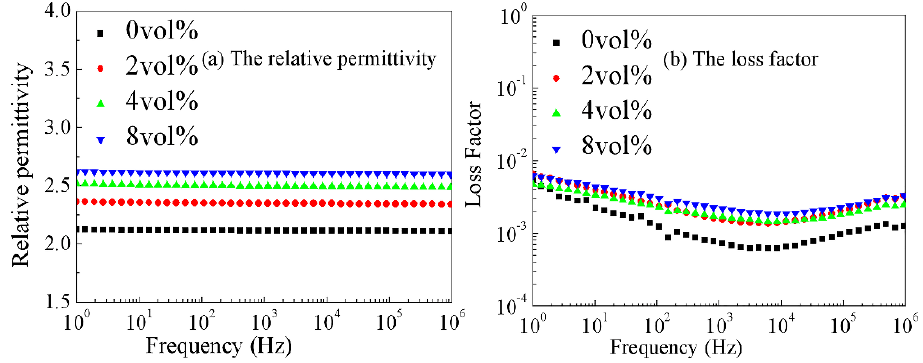
content: ( a ) The relative permittivity; ( b ) The loss